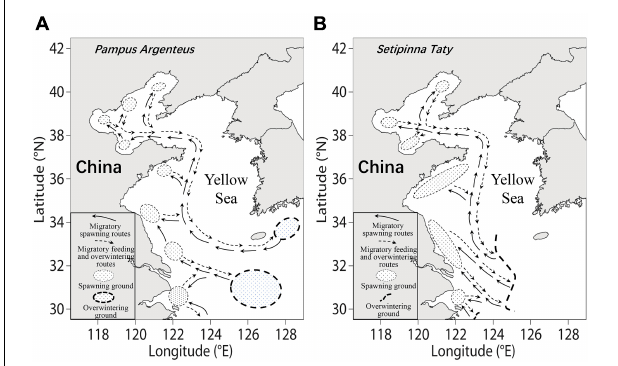
FIGURE 1 | Migration routes of (A) P. argenteus and (B) S. taty in the Bohai and Yellow Seas. Refer to Liu et al. (1990).